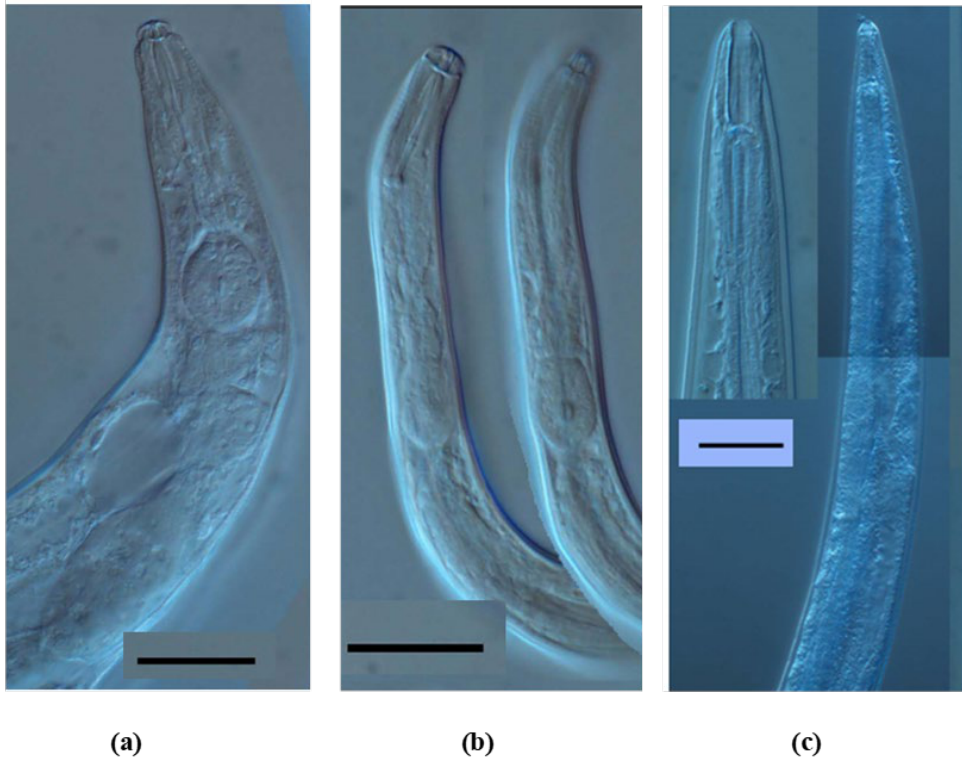
Figure 1. Diagnostic features of adults of nematodes species found inside male and female figs of Ficus hispida . Adults of Ficophagus cf. centerae ( a ) Martininema baculum ( b ) and Caenorhabditis sp. ( c ) showing their specific mouthparts. Bars represent 20 μm for ( a , b ) and 50 μm for ( c ).